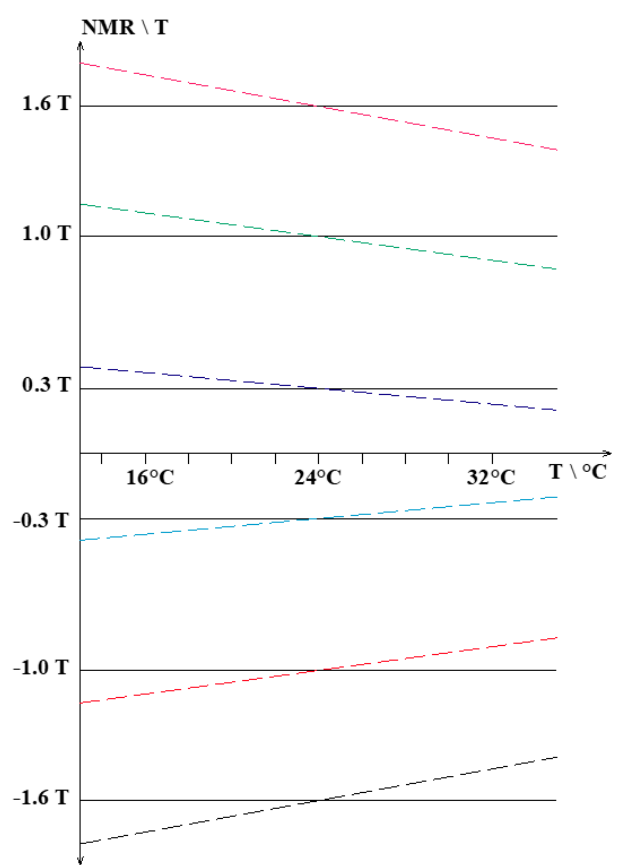
Figure 10. Theoretical modelling plot of the instrument output response in comparison to the NMR output for a temperature sweep. Sensitivity response of the instrument output is explained through the varying slope value across the magnetic field range. Electronics 2020 , 9 , x FOR PEER REVIEW